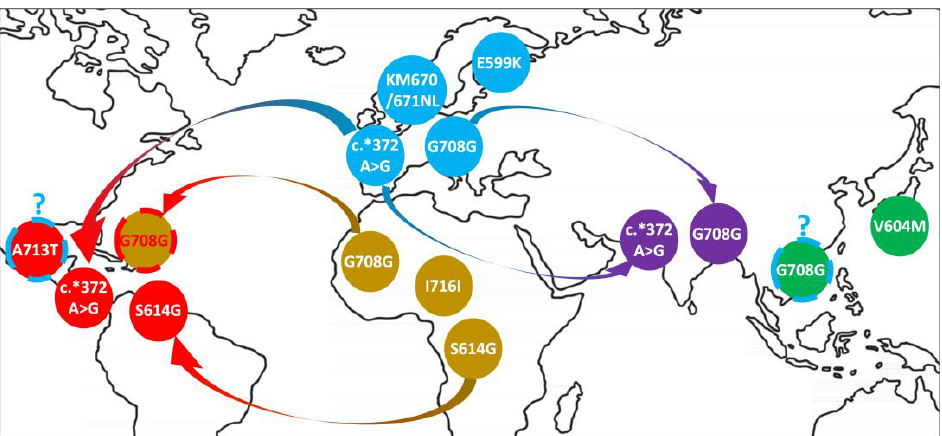
Figure 2. Possible origin and cross-population sharing of mutation-carrying segments. The Caribbean population of admixed origin is indicated by red text and red dashed borders. The putative European contributions to individuals carrying mutations A713T in America and G708G in Vietnam are indicated by a blue question mark and blue dashed borders.